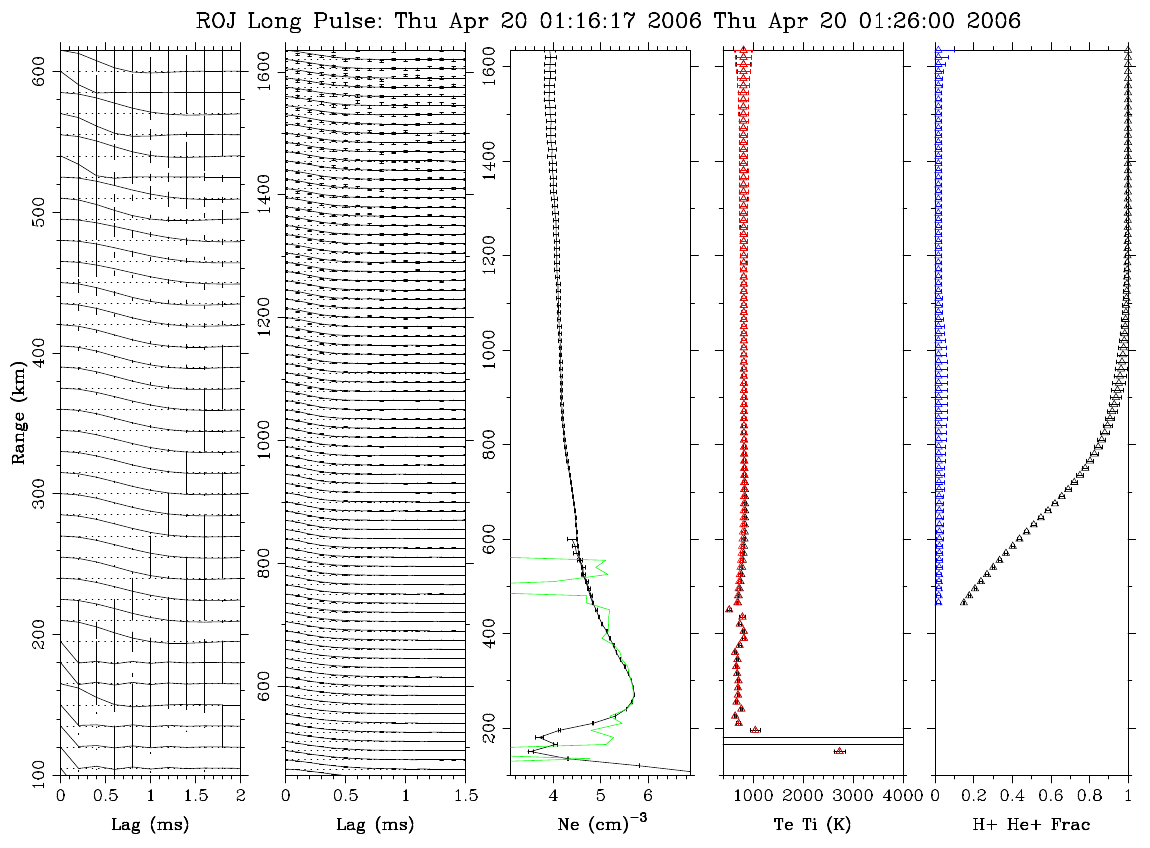
Fig. 4. Jicamarca profiles for 01:30 LT (06:30